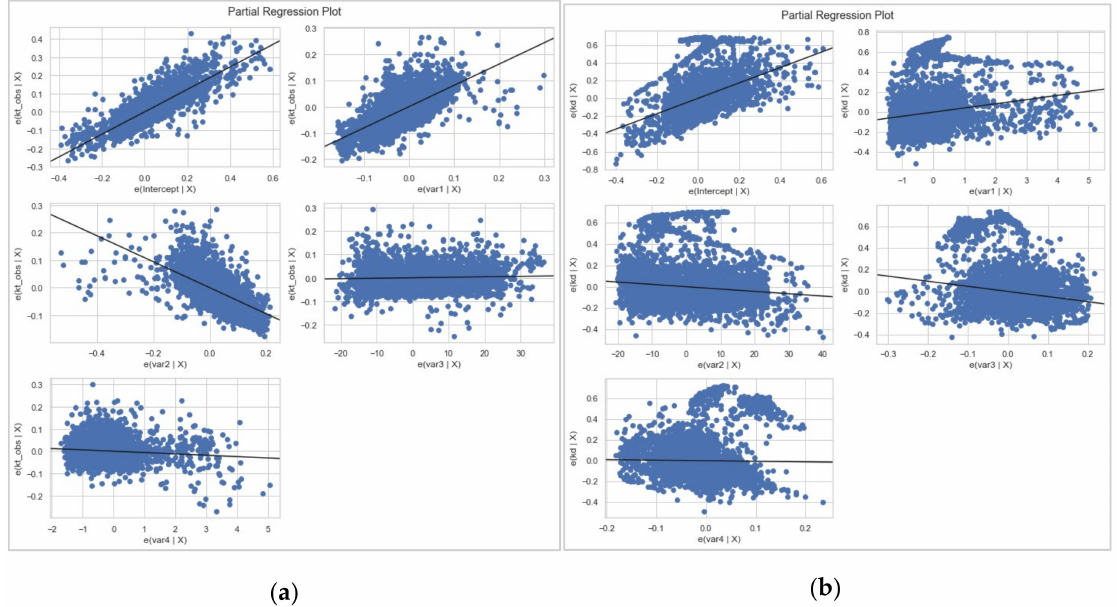
Figure 9. Partial regression plot under clear-sky conditions for ( a ) GHI and ( b ) DNI. The plots are scatter plots of residuals from the regression of Y on X ∼ i on the y-axis against residuals from the regression of X i on X ∼ i on the x-axis. The ordinary least squared fitting line is drawn in black, which indicates the coefficient of X i in the full multiple regression. Figure S1 shows the partial regression plot under cloudy-sky